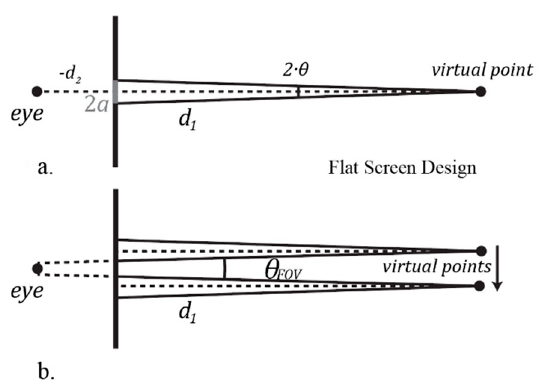
Figure 4. ( a ) The virtual point is limited by the aperture 2𝑎 and distance drawn. The angle allowed by these parameters depends on the maximum deflection angle of the device. ( b ) The maximum length perceived by the eye at any distance is found by dragging the aperture along the active region until the back-traced rays fall just barely on the eye. The angle from the eye to the virtual points defines the FOV.